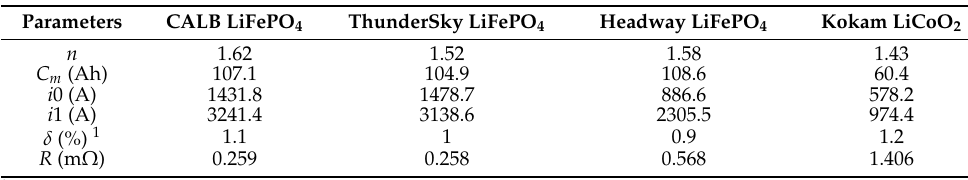
Table 3. Optimal values of parameters for modified Peukert’s Equation (7).